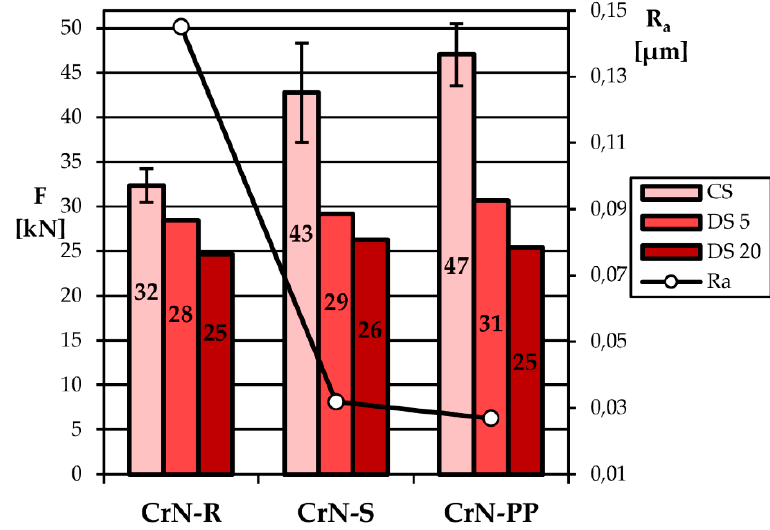
Figure 3. Maximal ejection force obtained for CrN pins with the different roughness in different experimental setups, error bars represent the ± 1, 95% confidence interval (CI). Table 2. Percentage (%) of the reduction in ejection force in delayed casting solidification (DS) experiments in comparison to values obtained in CS experiments.